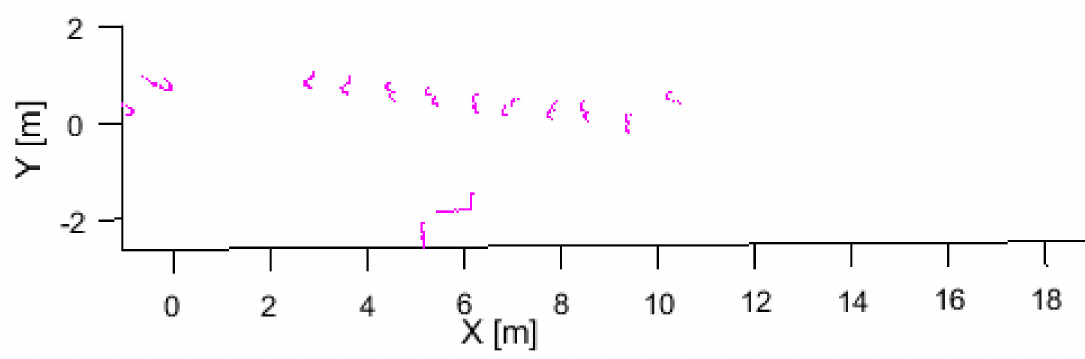
Figure 13. Dynamic objects in global coordinates.